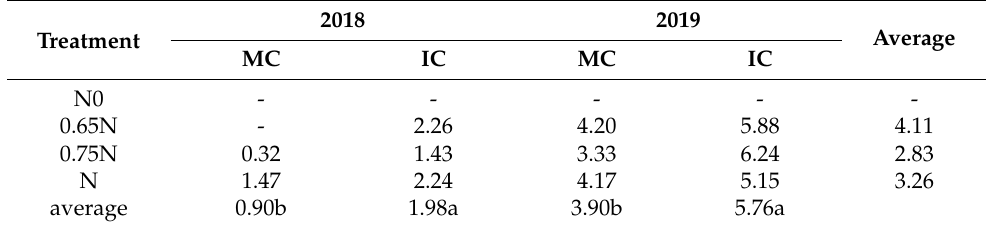
Table 3. Nitrogen fertilizer agronomic efficiency of oilseed rape under different treatments (kg kg − 1 ).